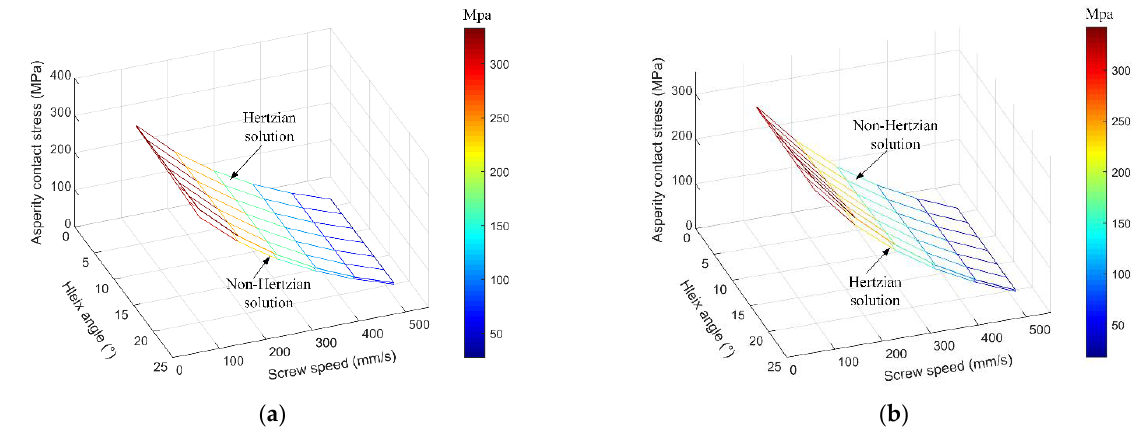
Figure 12. Comparison of the elastohydrodynamic stress between the Hertzian solution and non-Hertzian solution under different screw speeds. ( a ) Central elastohydrodynamic contact stress of point A . ( b ) Central elastohydrodynamic contact stress of point B .